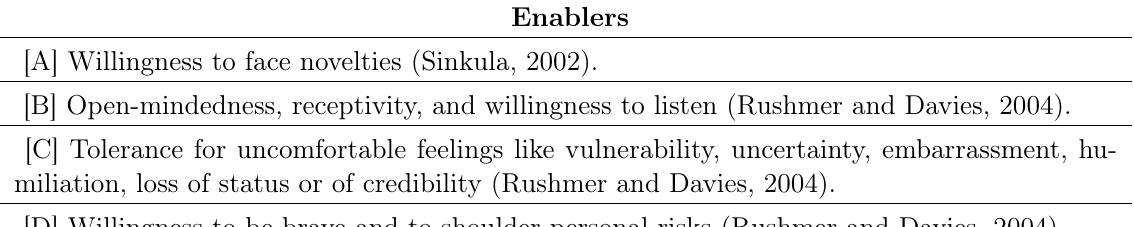
Table 1 . Personal Characteristics for Individual Unlearning